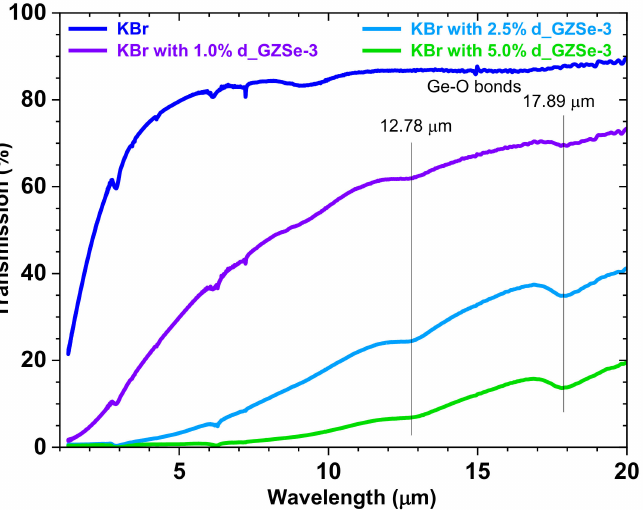
Figure 7. Transmission spectra of the KBr pellets with 1.0, 2.5 and 5.0% powder of